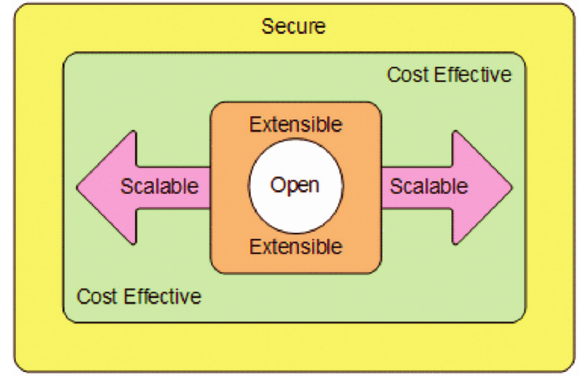
Figure 1. The PITT Model